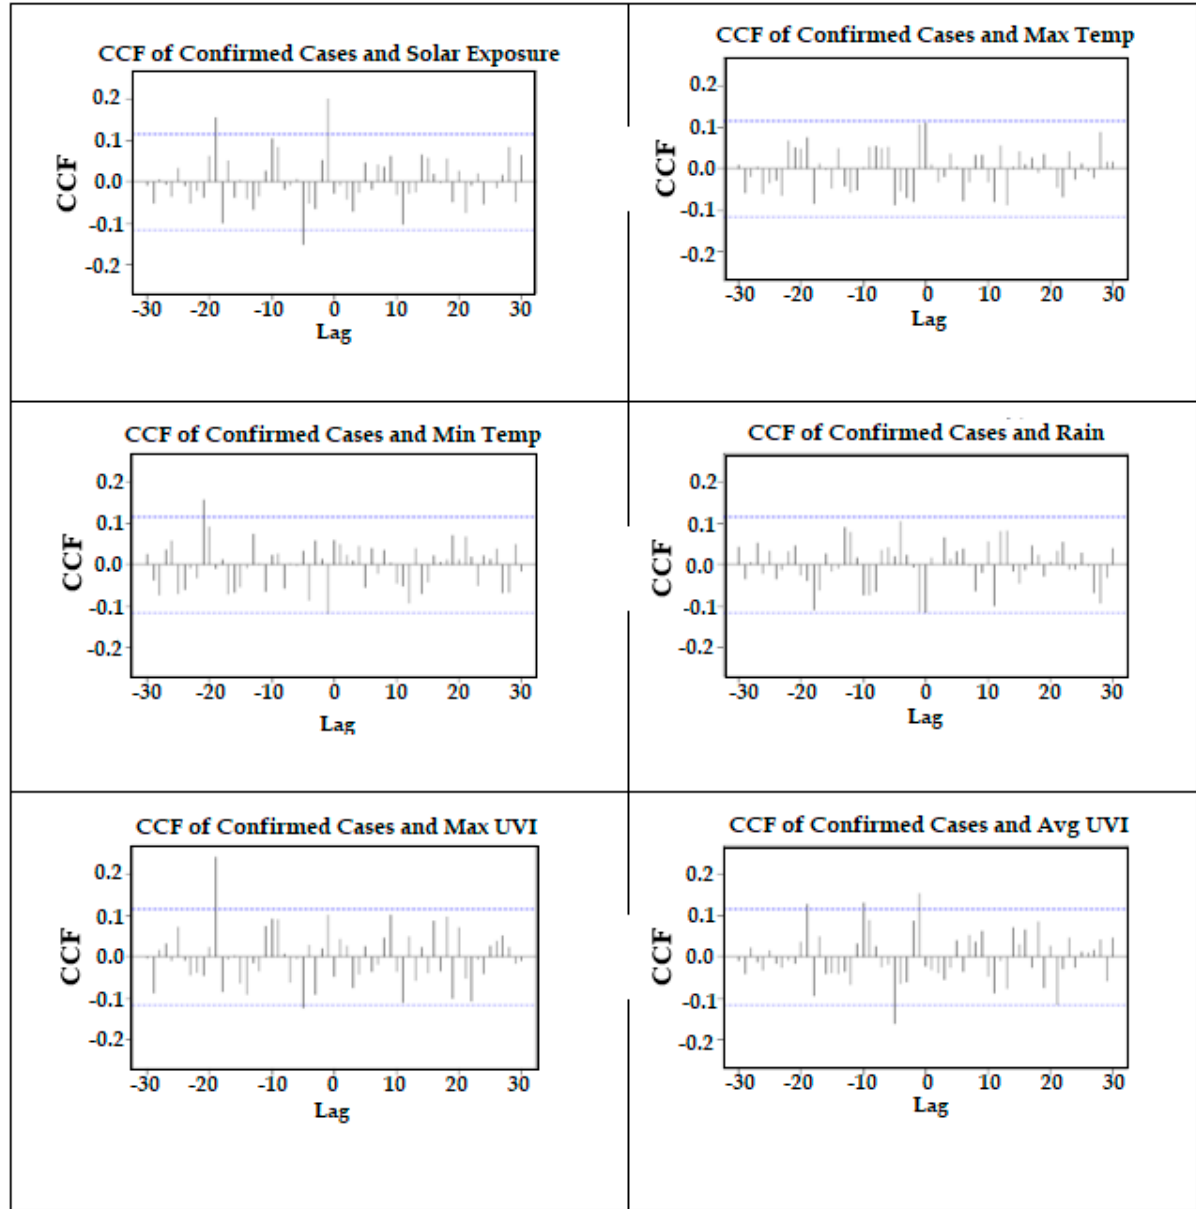
Figure 5. CCF of confirmed cases against each meteorological variable.